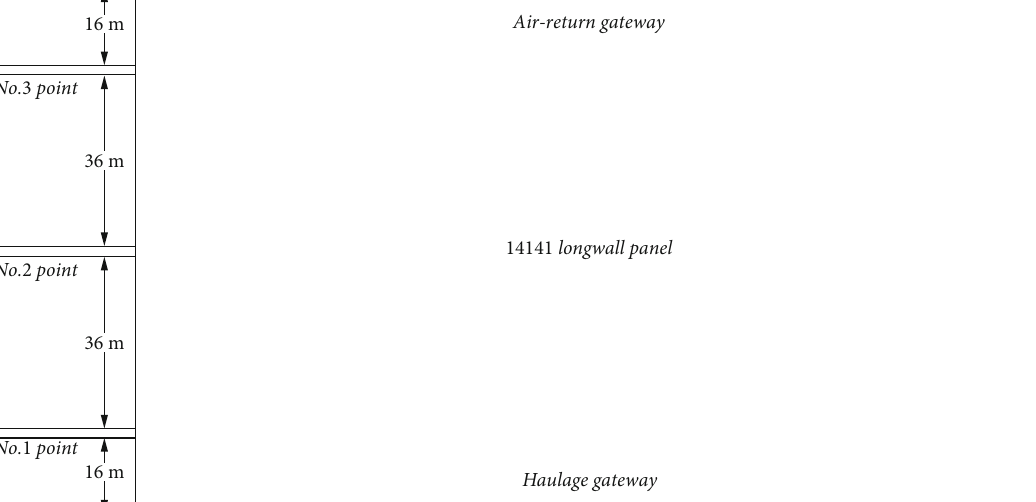
Figure 4: Roof rock weighting monitoring scheme.